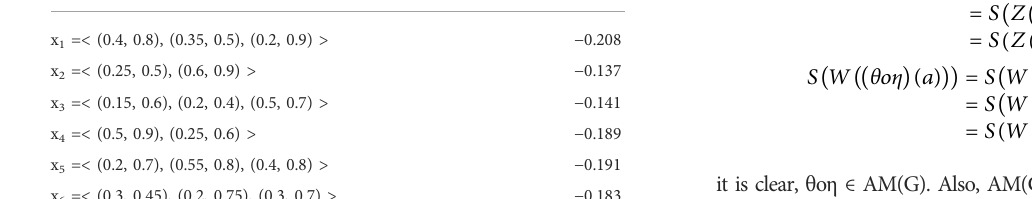
TABLE 4 VVHF membership of persons mental power. W Score